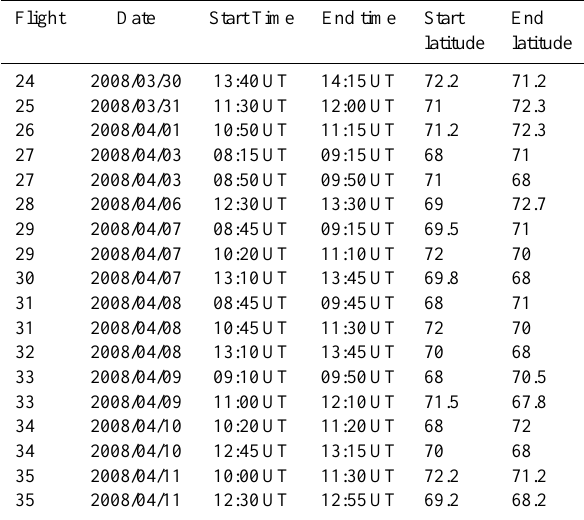
Table 1. Time and positions of the B-LNG lidar vertical cross sec- tions during the POLARCAT spring